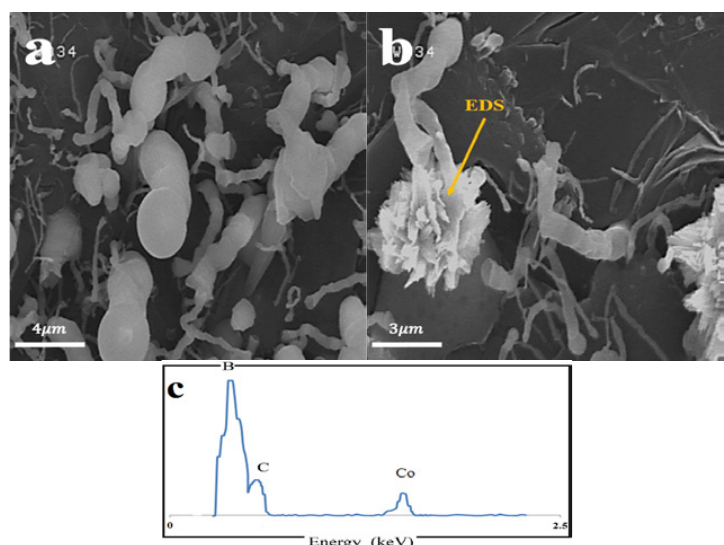
Fig. 8. the SEM image of B4 when the catalyst is applied to the crucible lid. (a) and (b) at 1500 ⁰C, (c) the EDS analysis result of the highlighted